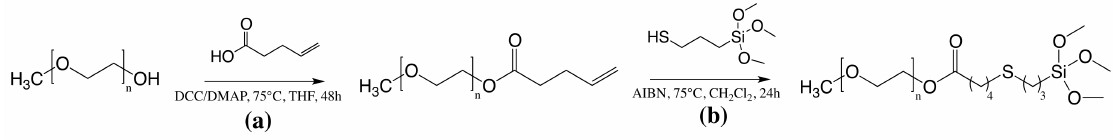
Figure 1. Synthesis of poly(ethylene glycol) (PEG) with short alkyl chain (C 8 ) and trimethoxysilane end group. ( a ) Steglich esterification. ( b ) Thiol-ene